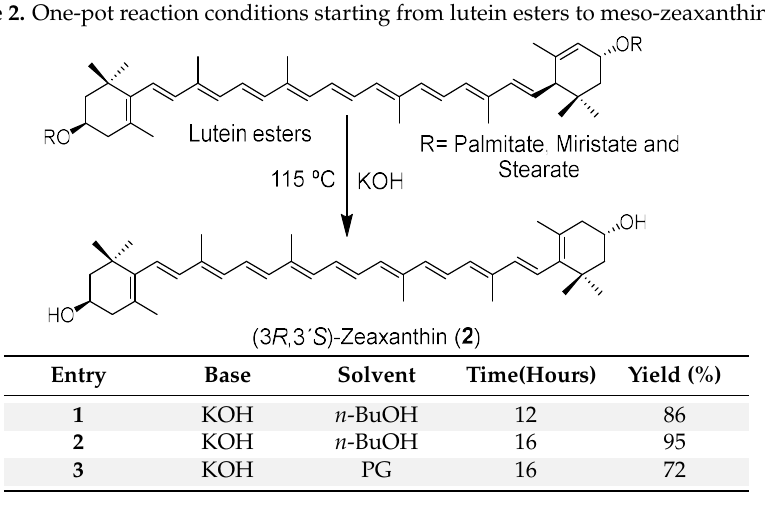
Table 2. One-pot reaction conditions starting from lutein esters to meso-zeaxanthin.